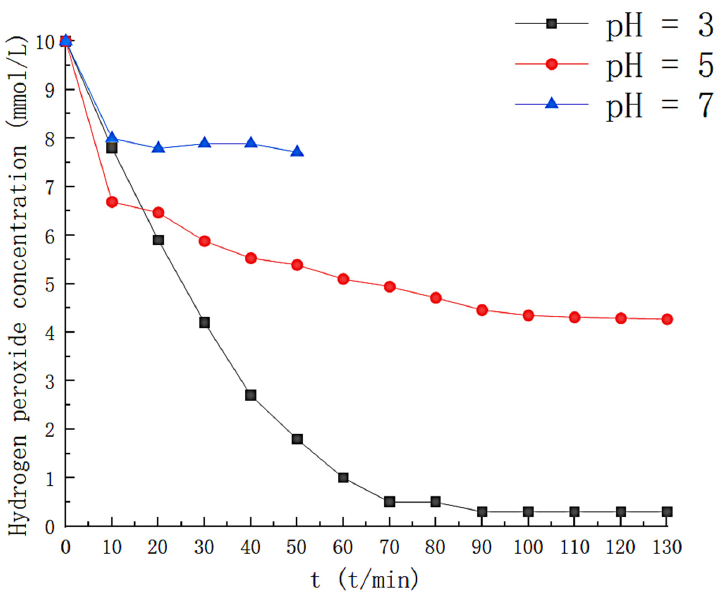
Figure 3. Effect of different pH on hydrogen peroxide.